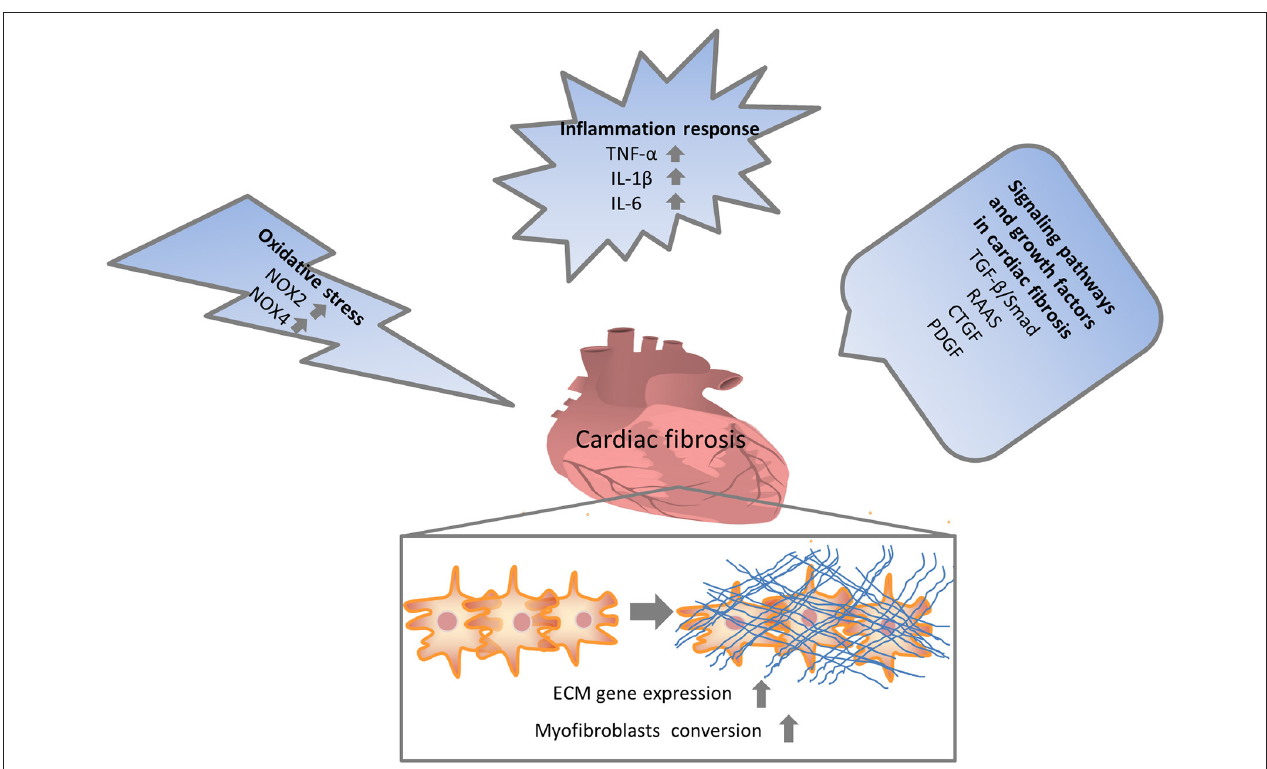
FIGURE 1 | Multiple mechanisms involved in cardiac fibrosis. Enormous initiating insults contributed to oxidative stress, inflammation and increased growth factors, which in turn directly or indirectly enhanced cardiac fibrosis. NOX, NAPDH oxidase; TNF, tumor necrosis factor; IL, interleukin; TGF, transforming growth factor; RAAS, renin-angiotensin-aldosterone system; CTGF, connective tissue growth factor; PDGF, platelet-derived growth